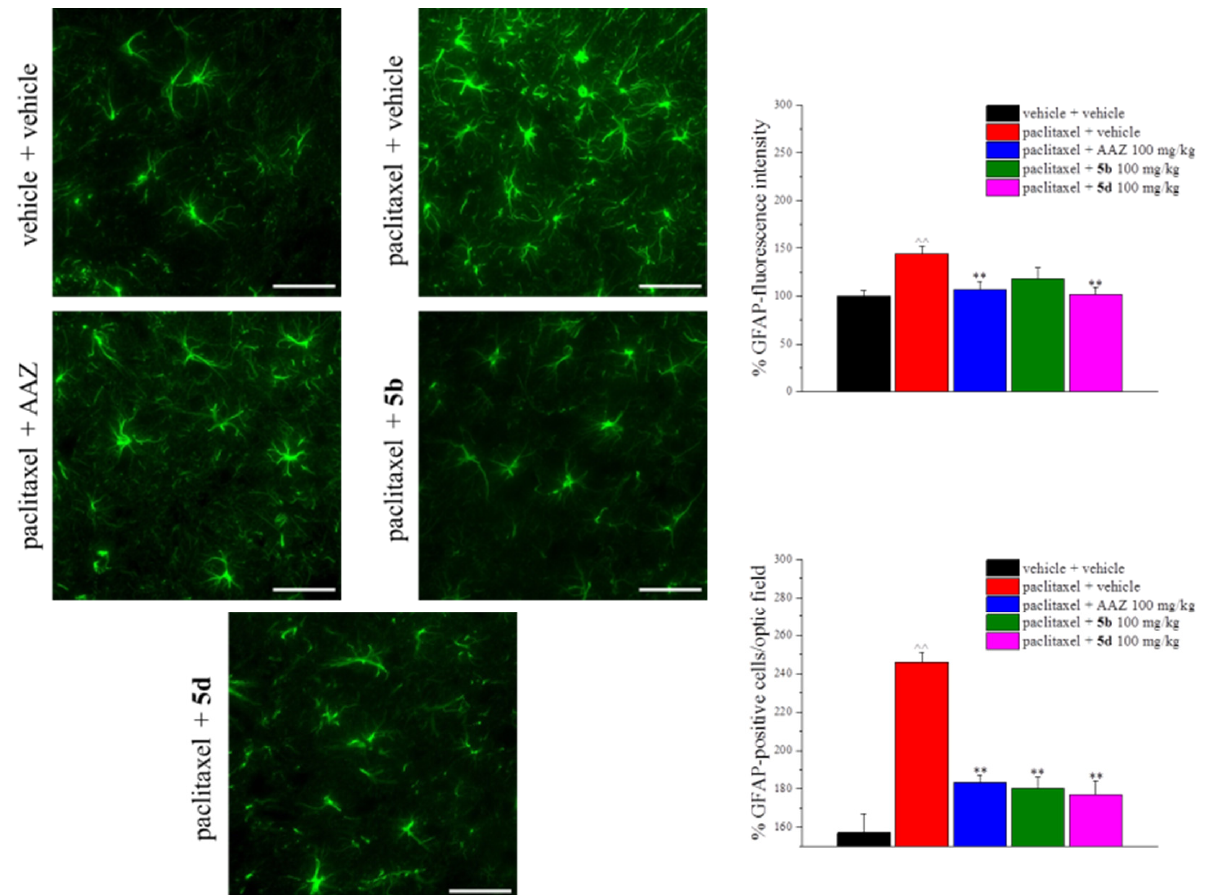
Figure 4. Effect of repeated CAI treatment on paclitaxel-induced astrocyte activation. Paclitaxel (2.0 mg/kg, i.p.) was administered on four days (1, 3, 5, and 8). Starting from the first day of paclitaxel injection and until the end of the experiment, 5b and 5d and AAZ were daily per os administered at 100 mg/kg. On day 15, at the end of the behavioral experiments, animals were sacrificed and the lumbar spinal cord was collected. The number of GFAP-positive cells was measured in the dorsal horn of the L4–L5 spinal cord. Transverse sections of the spinal cord imaged with a × 20 objective (scale bar = 50 µ m). Histograms show the quantitative analysis of GFAP fluorescence intensity and the number of GFAP-positive cells/optic field. Data are expressed as the mean ± S.E.M. of values from eight mice analyzed in two different experimental sets. ˆˆ p < 0.01 vs. vehicle + vehicle; ** p < 0.01 vs. paclitaxel + vehicle.